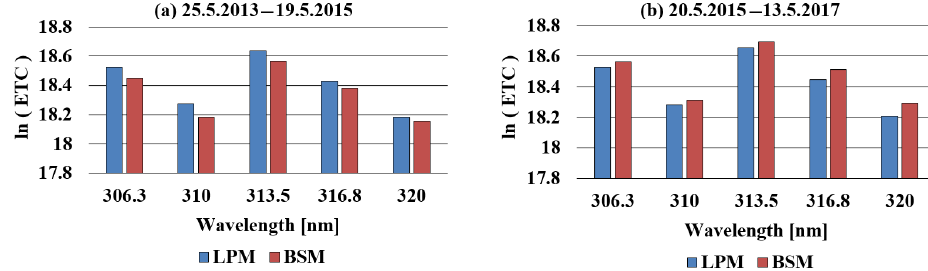
Figure 5. Comparison of ETC values for individual wavelengths for the LPM and BSM.